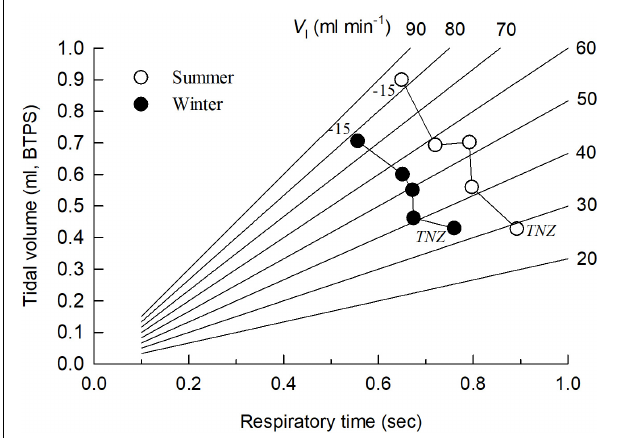
FIGURE 2 | Relationship between respiratory frequency (presented as the respiratory time, i.e., the time between two respiratory cycles) and tidal volume in summer-acclimatized (open symbols) and winter-acclimatized (closed symbols) great tits. Each point represents (from thermoneutral temperatures (TNZ) through 10, 0, –5 to –15 ◦ C) the mean value at an experimental ambient temperature, except at TNZ which is the mean value obtained between 20 and 30 ◦ C. Lines show values of iso-ventilation, i.e., combinations of tidal volume and respiratory frequency producing a constant minute ventilation volume.